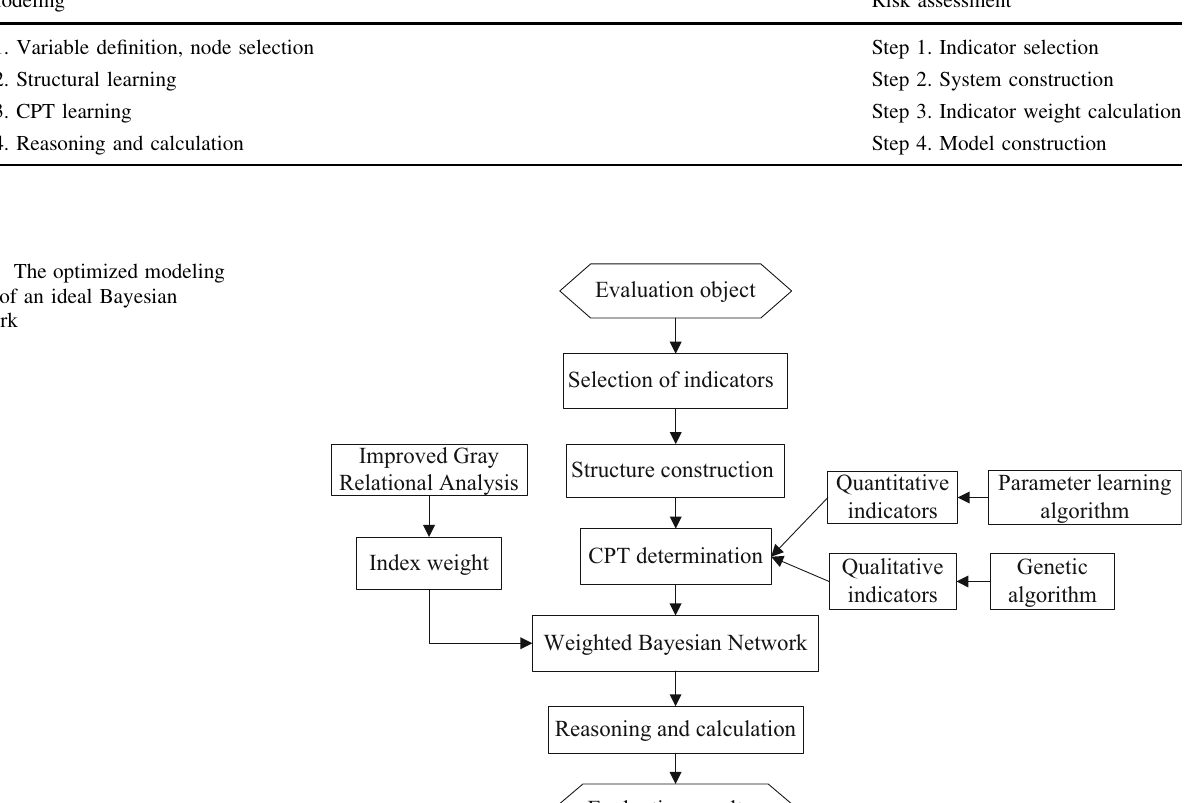
Table 1 Bayesian network modeling and assessment process BN modeling Risk assessment